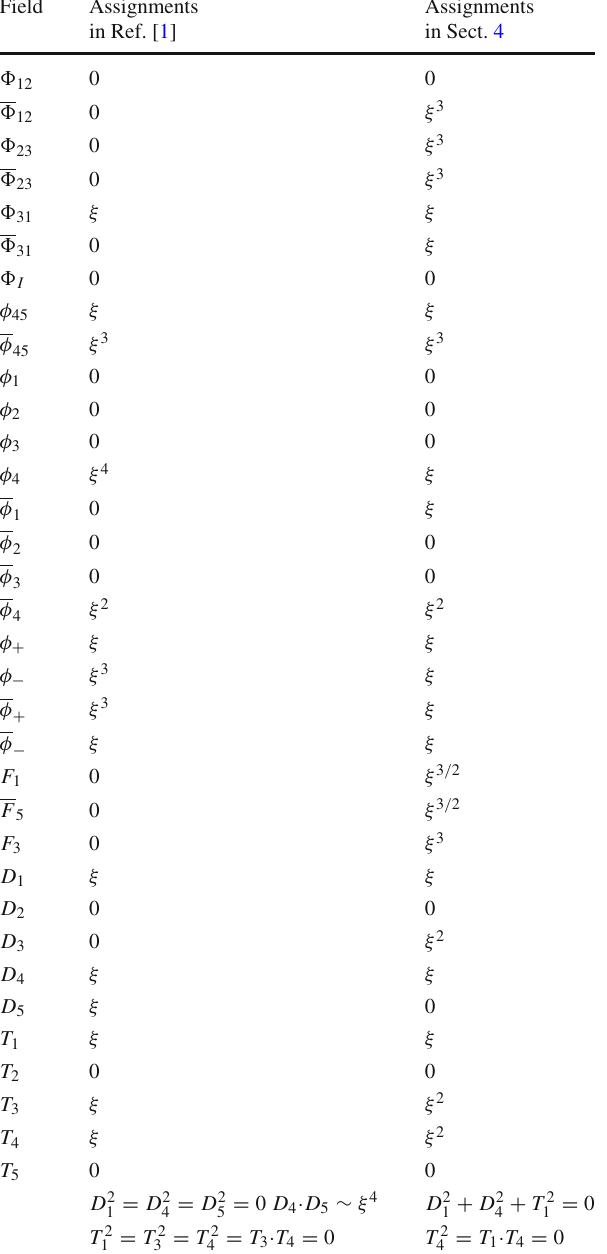
Table 1 Field VEV assignments in the F/D-flatness solution of Ref. [1] (column 2) and the solution derived here, in Sect. 4 (column 3)